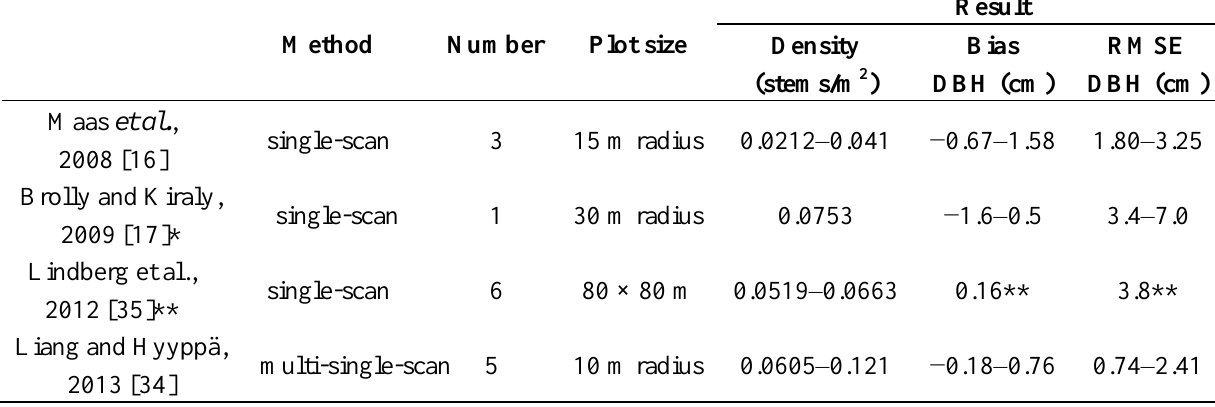
Table 8. Summary of the plot-level DBH estimate utilizing single-scan and multi-single-scan approaches reported in the previous references. Method Number Plot size